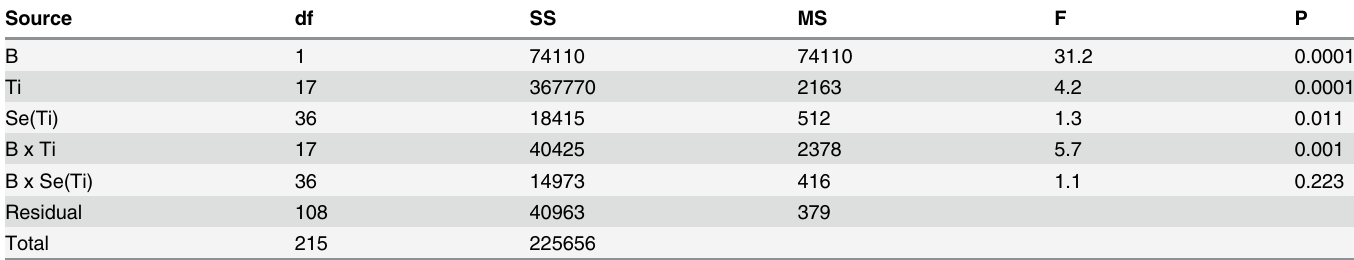
Table 1. Results of PERMANOVA analysis contrasting multivariate community structure across blooms (B, phytoplankton spring and summer blooms), time (Ti, long-term period from 1994 to 2011), season nested in time (Se(Ti), 3 months comprising each bloom) and their interactions. Shown are degrees of freedom (df), sums of squares (SS), mean squares (MS), F-ratios (F), and the Monte Carlo asymptotic P values